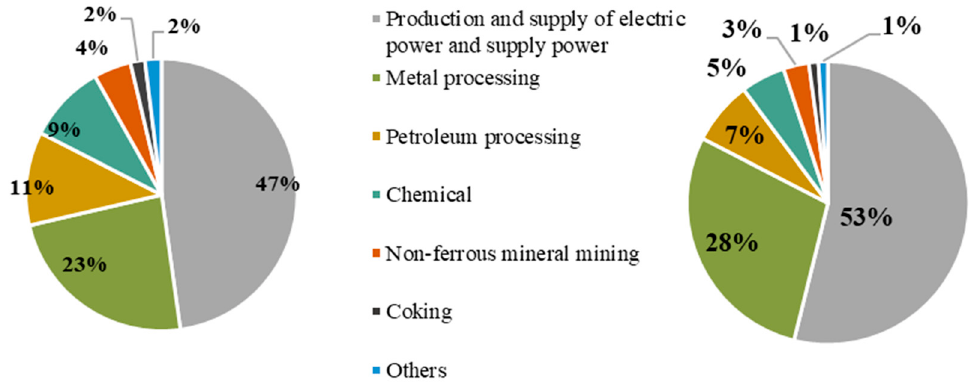
Figure 1. Contribution of di ff erent sectors to economic